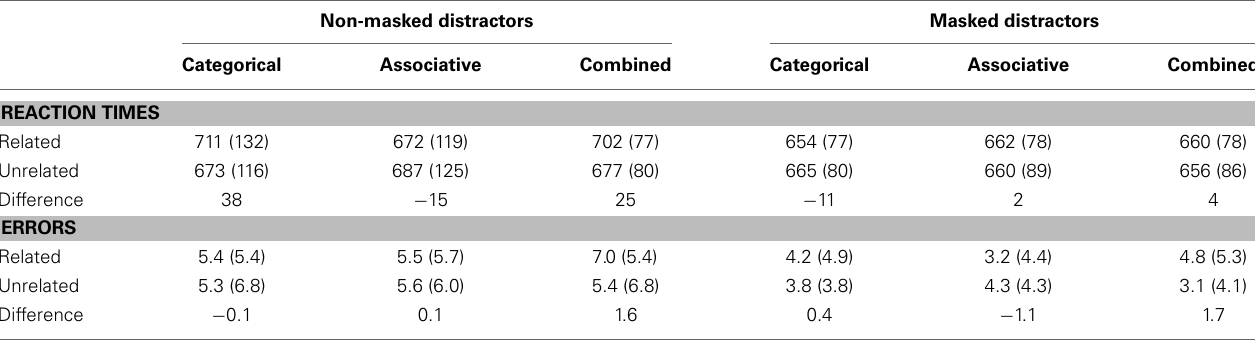
Table 2 | Reaction times (in milliseconds) and errors (in percent) by presentation mode (visible vs. masked distractor presentation), relatedness (related vs. unrelated), and type of relatedness (categorical, associative,